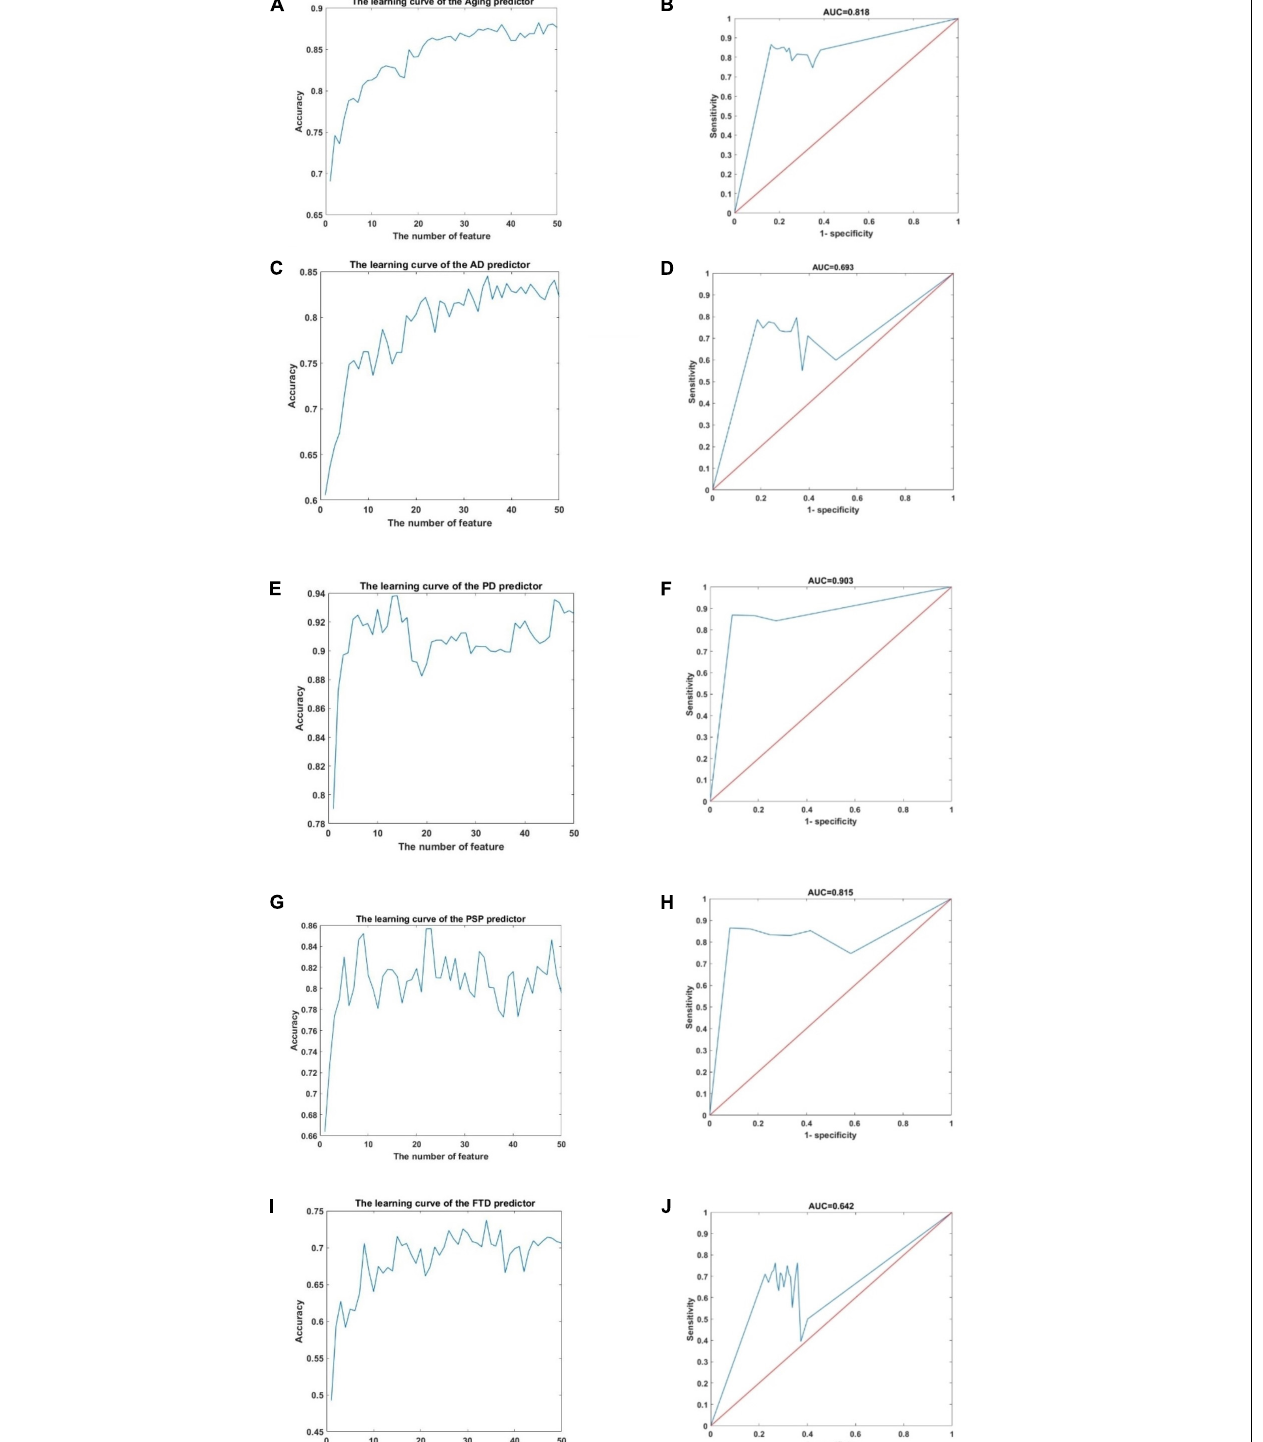
Frontiers in Genetics |